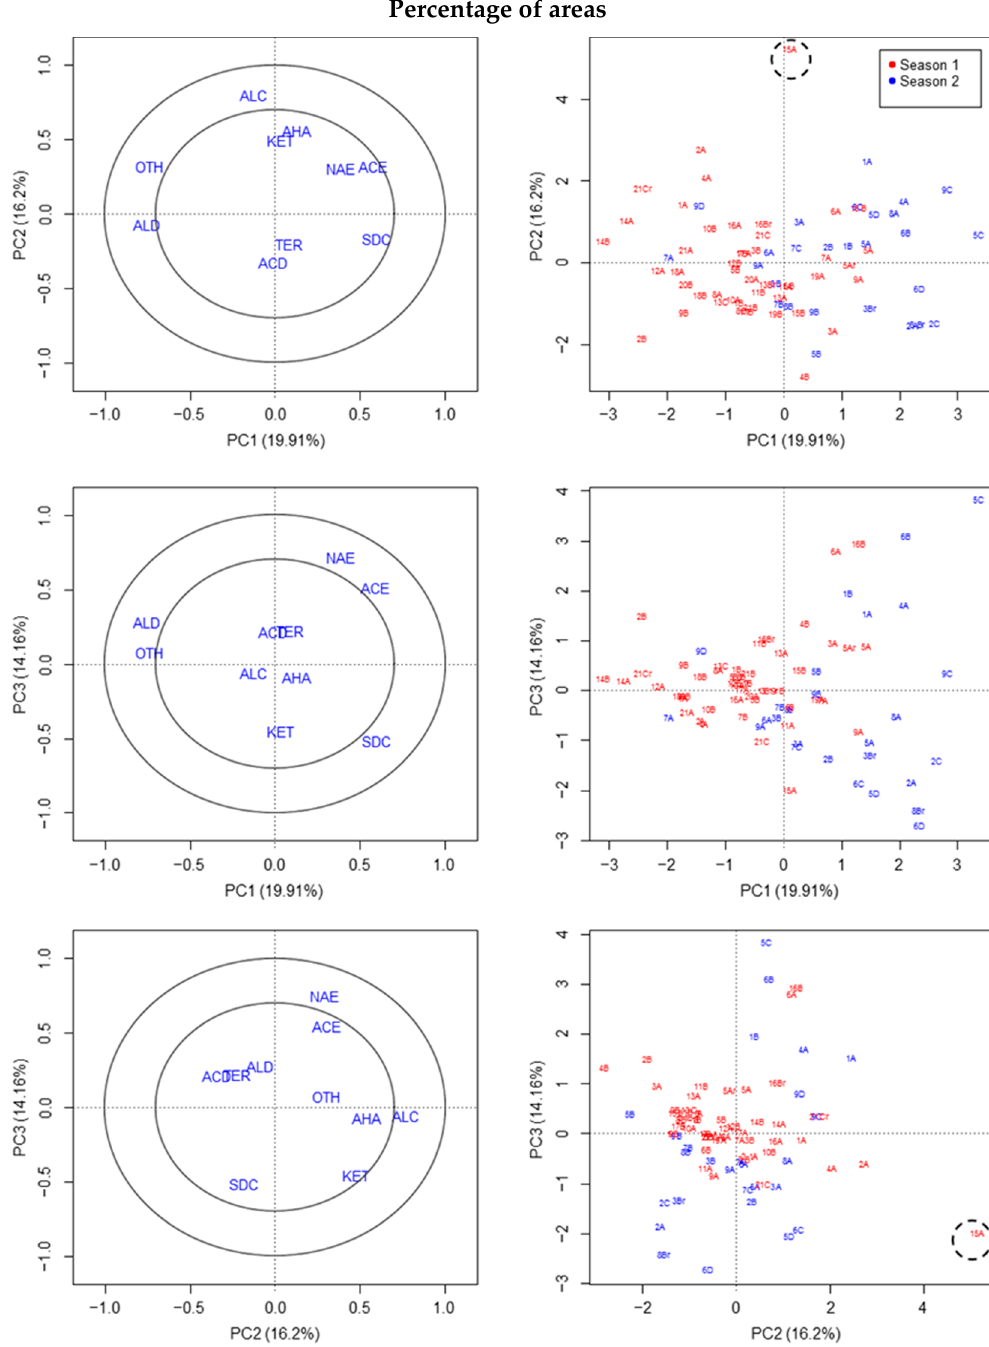
Figure 2. Correlation ( left ) and score ( right ) plots of the first three components of the PCA (with 50.27% of explained variance) applied to compound classes of aroma variable of percentages of different compound classes based on total area counts of such compounds with match quality >50, and without exogenous compounds, obtained in two seasons. ACE, acetate ester; NAE, non-acetate ester; ALD, aldehyde; ALC, alcohols, KET, ketones; SDC, sulfur derived-compounds; TER, terpenes; AHA, alkanes and aliphatic compounds; OTH, other compounds. Circles represent r 2 = 50% and 100% variability explained by the components. Potential outliers are marked by dashed black line.